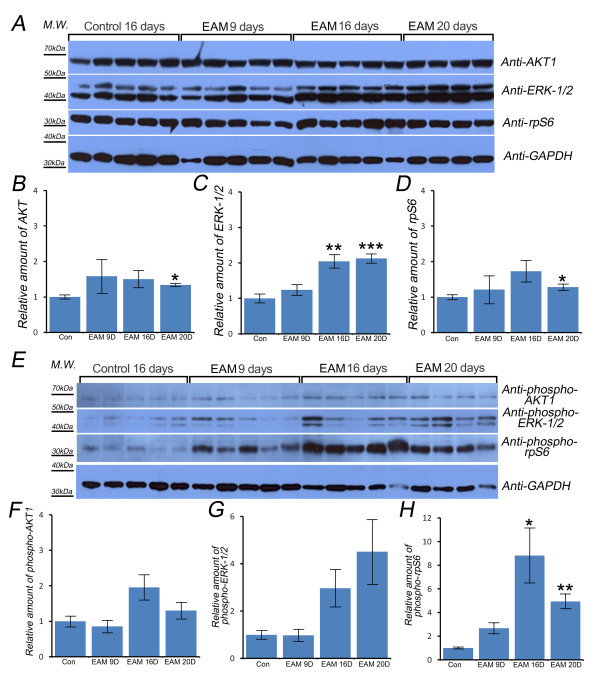
Total ERK-1/2 and phosphorylated-rpS6 were increased in EAM heart tissue. The levels of AKT1, ERK-1/2, and rpS6 were examined (A). GAPDH was used as a loading control. There was no difference between the control rats and the EAM day 9 and day 16 rats for AKT1 or rpS6 (B, D). However, the levels of total ERK-1/2 were significantly increased in EAM days 16 and 20 (C). The levels of phosphorylated AKT1, ERK-1/2, and rpS6 were quantified (E). There was no activation of AKT1 signaling in EAM rats (F). EAM day 16 and day 20 rats appeared to have increased amount of phosphorylated ERK-1/2 (G). The levels of phosphorylated rpS6 were significantly increased in EAM day 16 and day 20 rat heart tissues (H). * indicates p < 0.05. ** indicates p < 0.01. *** indicates p < 0.001.